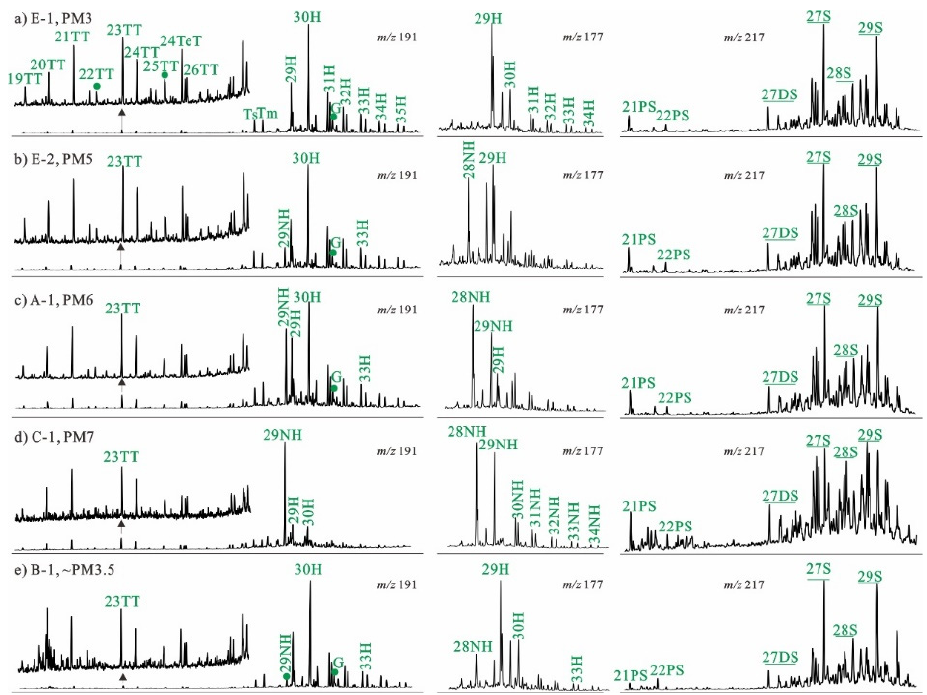
Figure 3. Mass chromatograms of selected oils with different degrees of biodegradation (PM Scale) showing the distribution of terpanes ( m / z 191), 25 ‐ norhopanes ( m / z 177), and steranes ( m / z 217). TT: tricyclic terpane; TeT: tetracyclic terpane; Ts: 18 α (H) ‐ trisnorneohopane; Tm: 17 α (H) ‐ trisnorhopane; H: Hopane; G: gammacerane; NH: 25 ‐ norhopane; 21 ‐ 22S: PS: pregnene; DiaS: diasterane; RS: regular